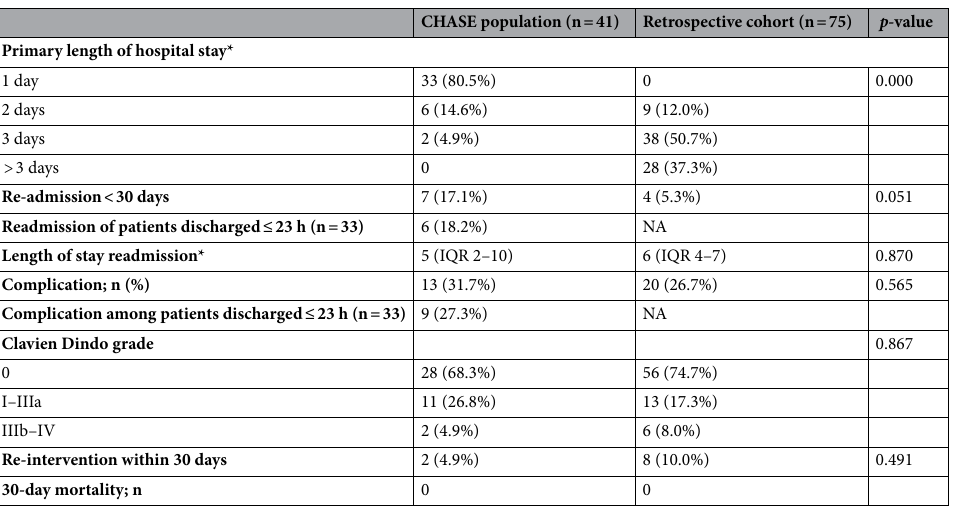
Table 3. Hospital and surgical data; primary and secondary outcomes. NA not applicable; *In median